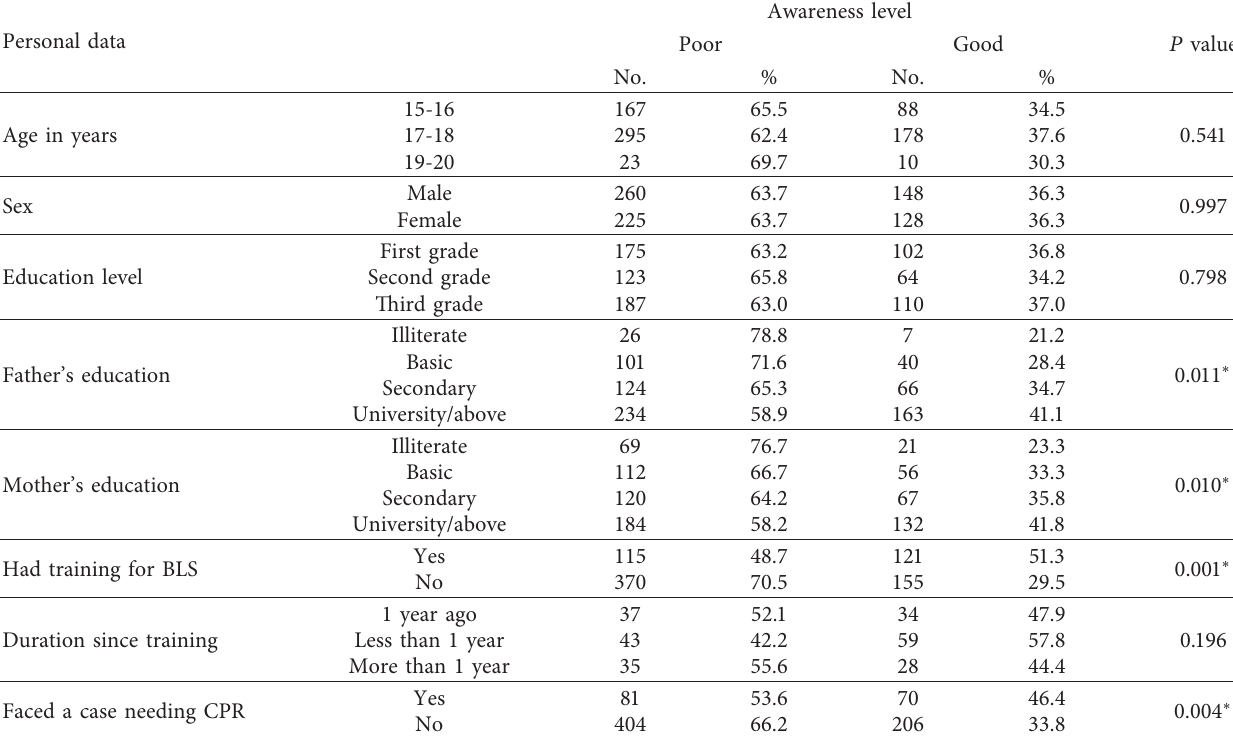
Table 4: BLS awareness of secondary school students in Abha City, southern Saudi Arabia, by demographics. Personal